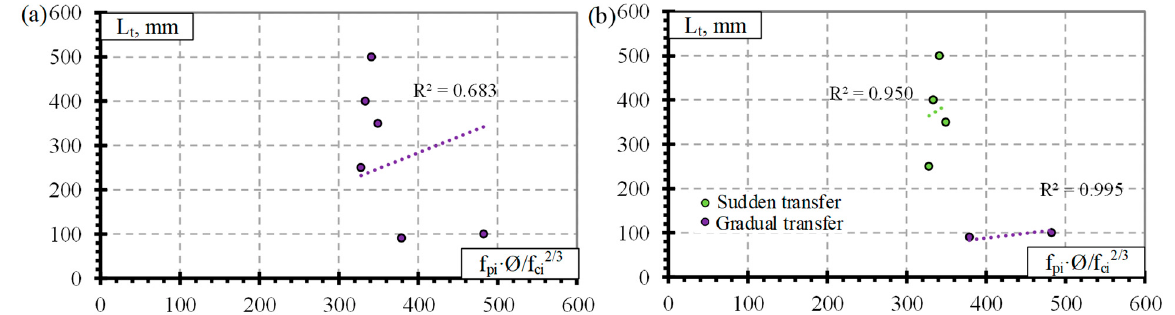
f / f ⋅∅ : ( a ) all : ( a ) all pi ci ci